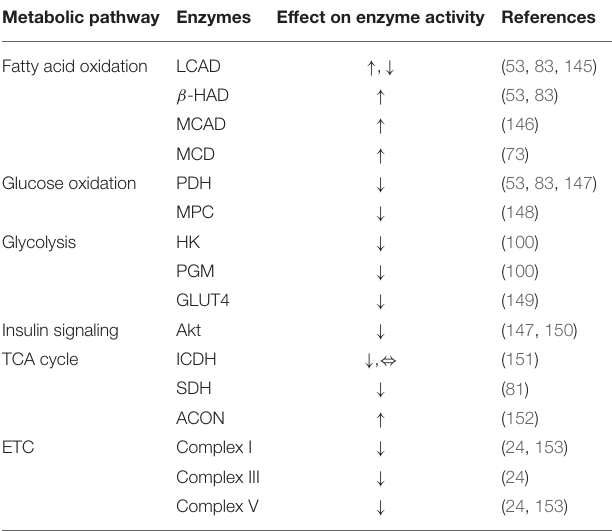
TABLE 1 | Effect of lysine acetylation on major metabolic enzymes in the heart. Metabolic pathway Enzymes Effect on enzyme activity